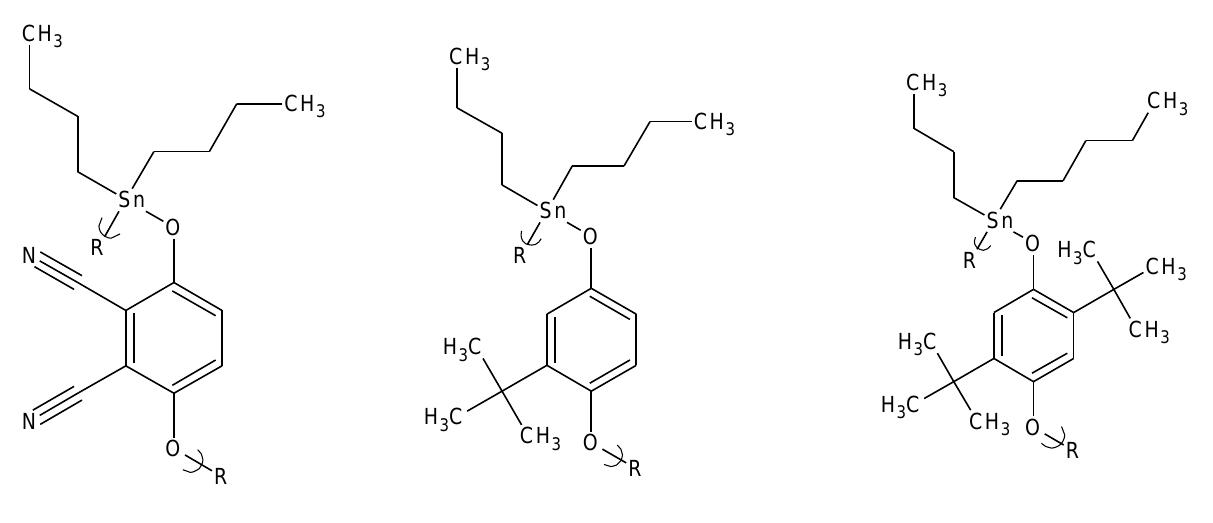
Figure 4. Repeat units for the dibutyltin polyethers derived from (left to